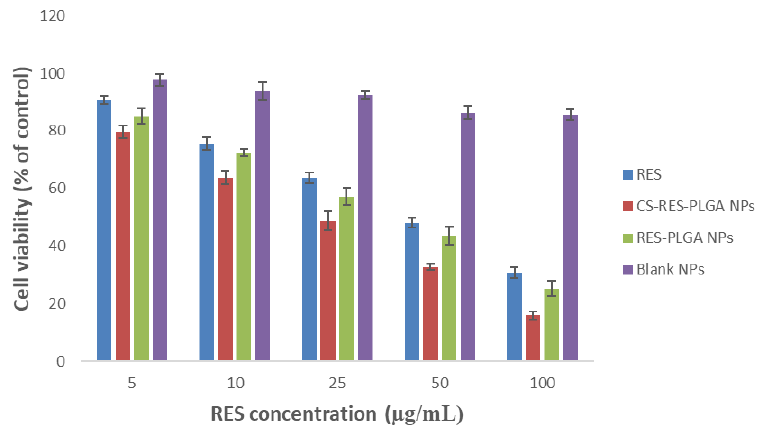
Figure 9. In vitro cytotoxicity of free RES, CS coated RES-PLGA NPs, RES-PLGA NPs and blank CS-coated PLGA NPs (blank NPs) in H1299 cells after 24 h incubation.